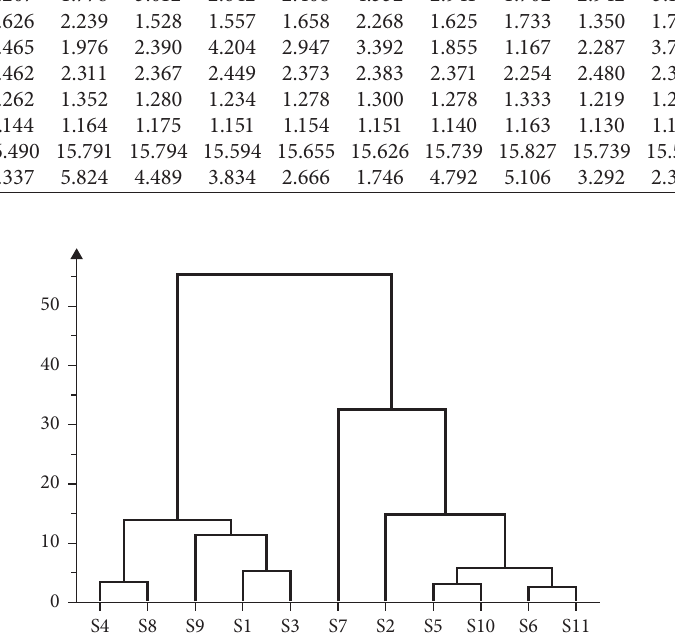
Figure 2: Cluster analysis of 11 batches of AMR.